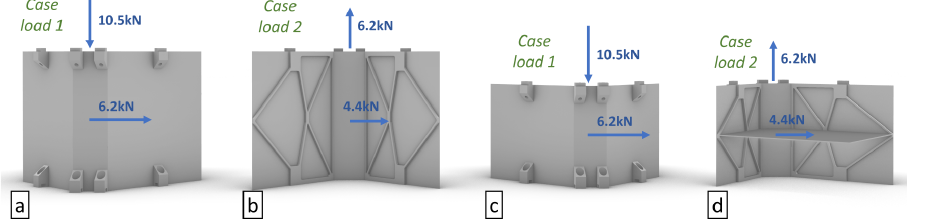
Figure 3. Sketch of module 1 ( a , b ) and module 2 ( c , d ) with the indication of the structural load for case 1 ( a , c ) and case 2 ( b , d ).